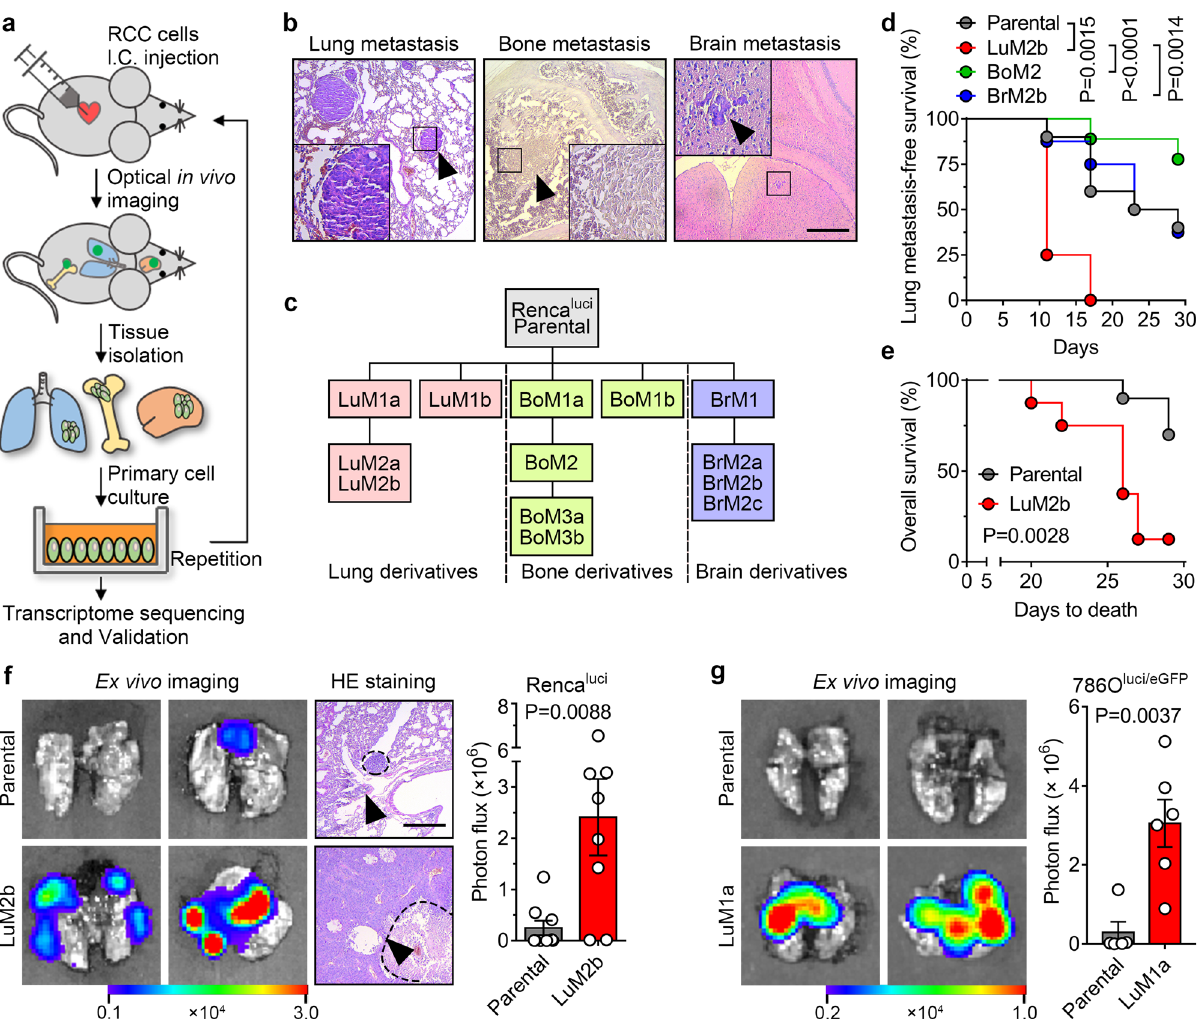
Fig. 1 Isolation, characterization, and analysis of lung metastatic derivatives. a Construction of the multi-organ metastasis model and screening of organospeci fi c metastatic cell derivatives. I.C., intracardiac. b Hematein-eosin (H&E) staining of lung, bone, and brain metastases (arrowheads) by Renca luci cells. Scale bar, 400 μ m. c Flowchart of the in vivo selection of lung, bone, and brain-speci fi c metastatic subpopulations from Renca luci cells. d Kaplan – Meier survival curves for lung metastasis-free survival of Renca luci cells and representative derivatives (Parental, n = 10 mice; LuM2b, n = 8 mice; BoM2, n = 9 mice; BrM2b, n = 8 mice). e Kaplan – Meier survival curves for overall survival of Renca Parental and Renca LuM2b cells (Parental, n = 10 mice; LuM2b, n = 8 mice). f Representative ex vivo bioluminescent and H&E images of lung metastases at 30 days after I.C. injection of Renca luci cells (Parental, n = 9 mice; LuM2b, n = 8 mice; left panel) and quanti fi cation of the photon fl ux (right panel). Scale bar, 400 μ m. g Representative ex vivo bioluminescent images of lung metastases at 90 days after I.C. injection of 786O luci/eGFP cells (Parental, n = 5 mice; LuM1a, n = 6 mice; left panel) and quanti fi cation of the photon fl ux (right panel). In f and g , the data are presented as mean ± SEM. Two-sided log-rank test was used for statistical analysis of ( d ) and ( e ), two-tailed Student ’ s unpaired t -test for ( f ) and ( g ). Source data are provided as a Source data fi